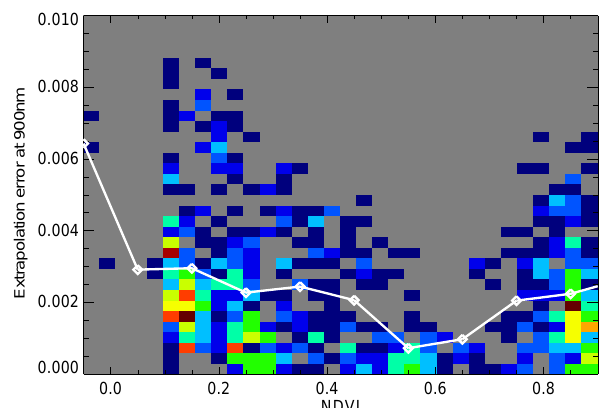
Fig. 7. Normalized frequency of distribution of error of linearly extrapolated surface albedo at 900nm (color coded) and resulting error parametrization (white curve) as a function of